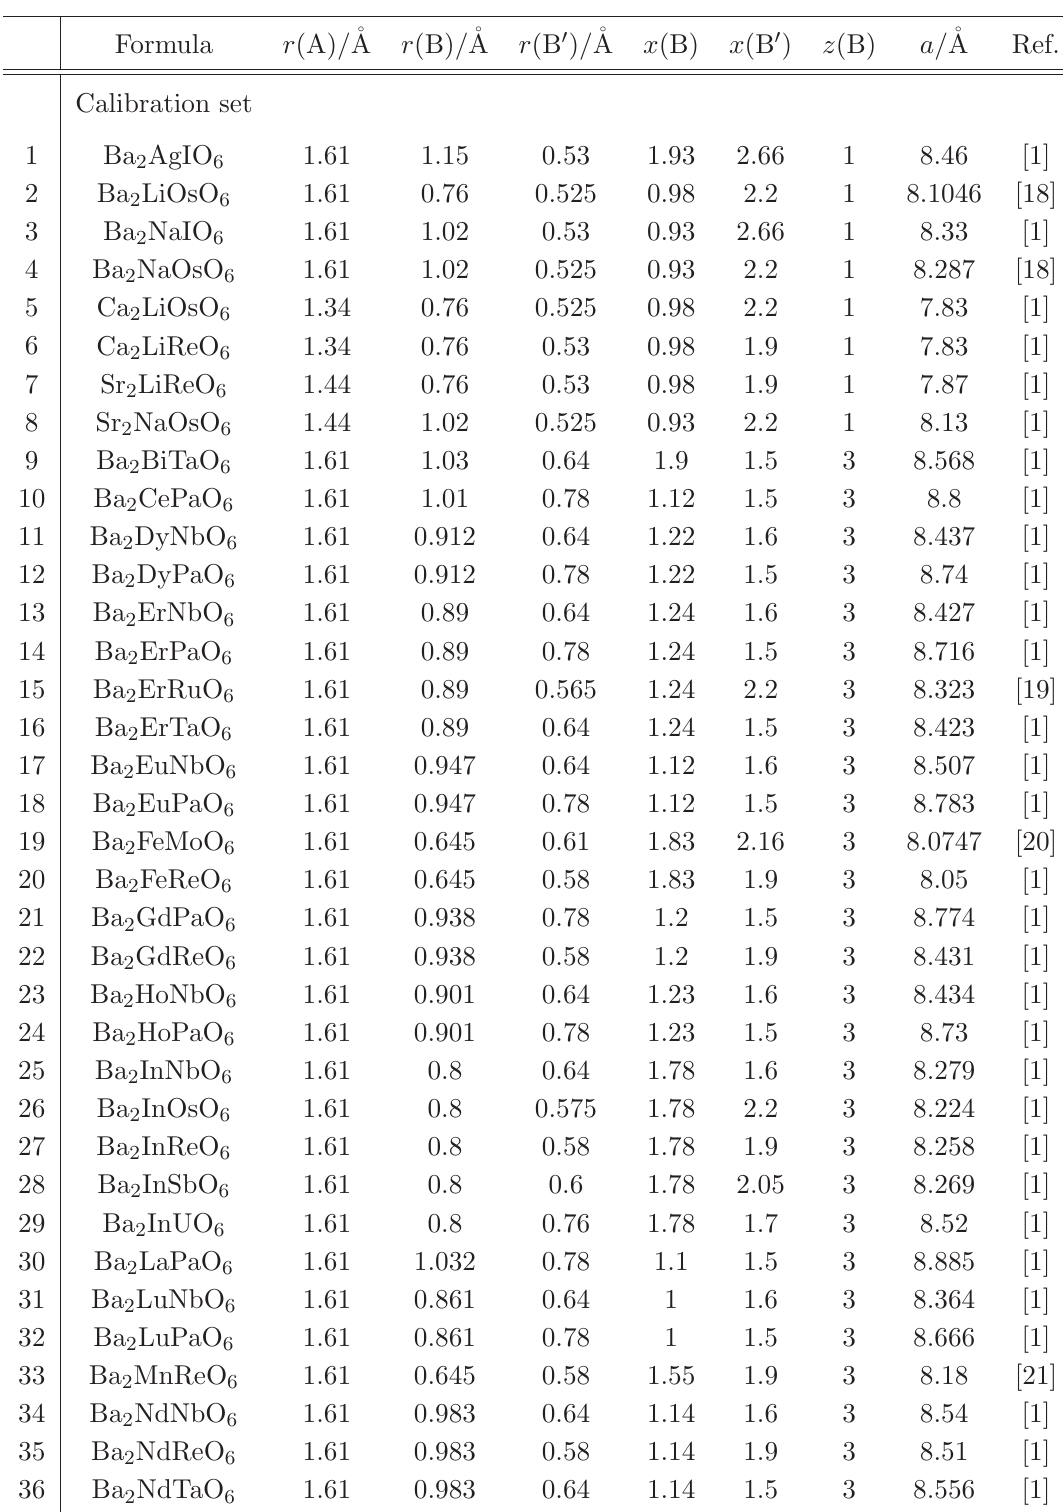
∗ Some literature data [33] refer this compound as rhombohedral; ∗∗ The value for the pseudocubic unit cell parameter was taken. Table 1 Input data in the analysis: radii of the constituents ( r ), electronegativity of the B- cations ( x ), the oxidation state of B-cation ( z ) and lattice parameter ( a